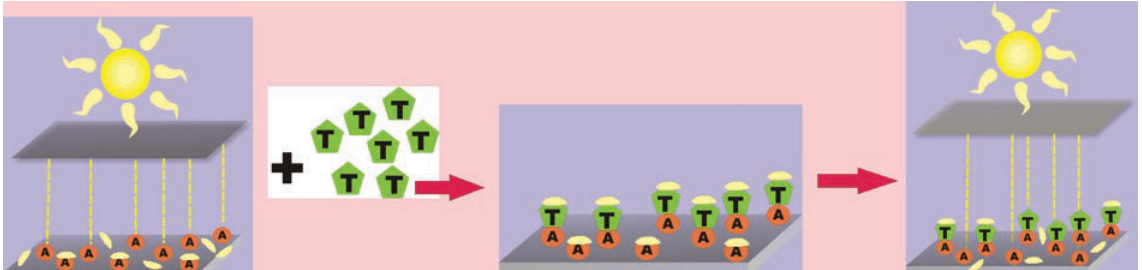
Figure 3. Photolitography